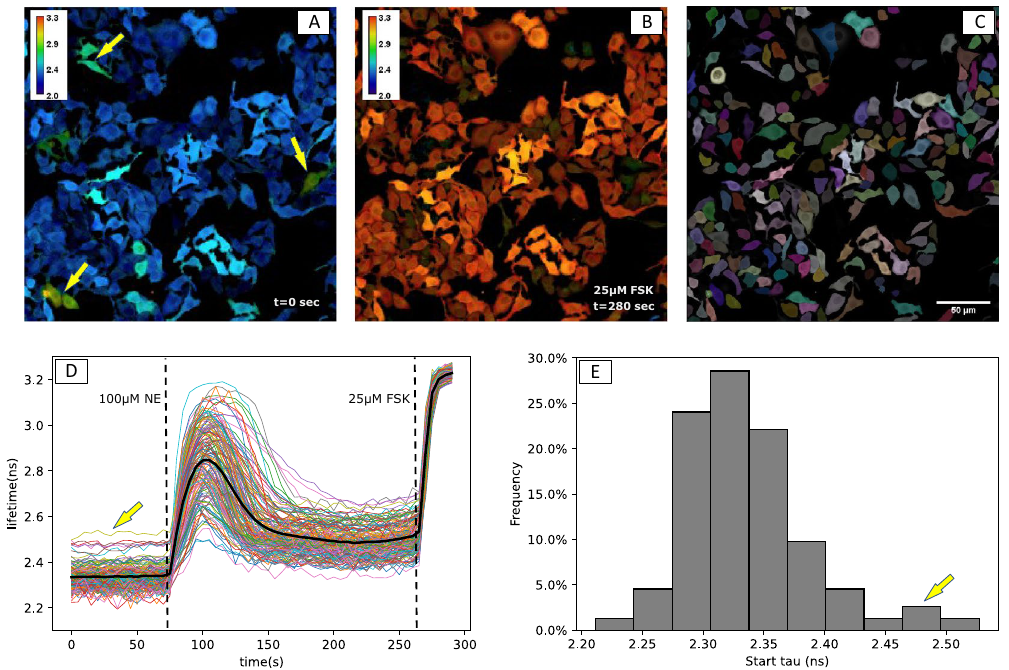
Figure 1. Detection of dynamic changes in cAMP levels in HeLa cells by FLIM. ( A – C ) Cells expressing the FRET-FLIM sensor Epac-S H189 are imaged at rest ( A ) and after stimulation with forskolin (FSK). ( B ) Calibration bar: lifetime in ns. Panel ( C ) shows the ROIs (color-coded) for each individual cell, as segmented using Cellpose, overlayed with fluorescence intensity. ( D ) Single cell FLIM time-lapse traces extracted from the same experiment show the transient response to stimulation with a 20-s pulse of the agonist, 100 µM norepinephrine (NE). The bold black line represents the mean of all cells. NE was added at t = 70 s and for calibration FSK was added at t = 265 s. ( E ) Distribution of the baseline values (average of 20 samples for each cell). Yellow arrows in ( A , D and E ) indicate cells with higher baseline